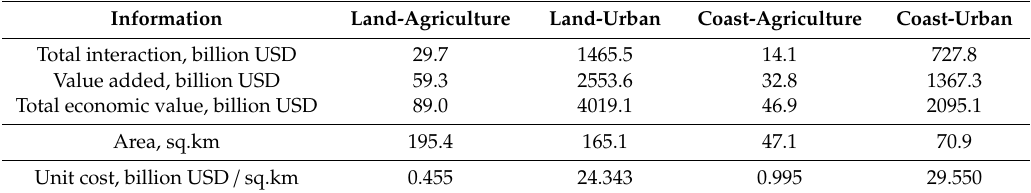
Table 4. Total economic value and unit cost of the MRIO sector for Okinawa